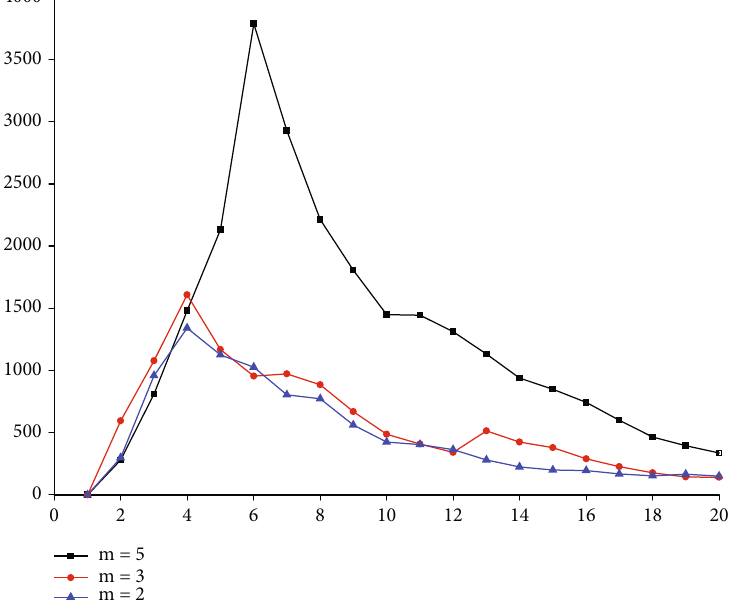
Figure 8: The number of damage points per loading step of rock mass with di ff erent